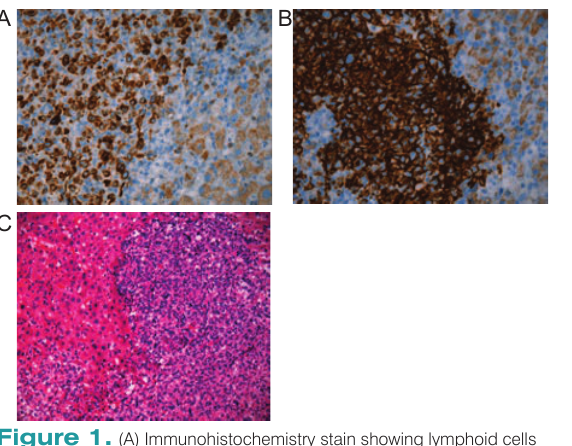
Figure 3. (A) Immunohistochemistry stain showing tumor cells with CD34 positivity (magnification 200x), (B) Kaposi sarcoma (skin tumor cells) in HE stain (magnification